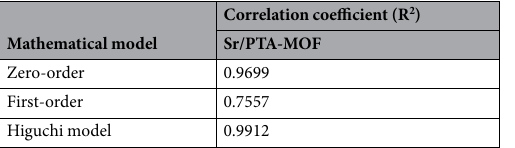
Table 1. Correlation coefficient (R 2 ) obtained for each